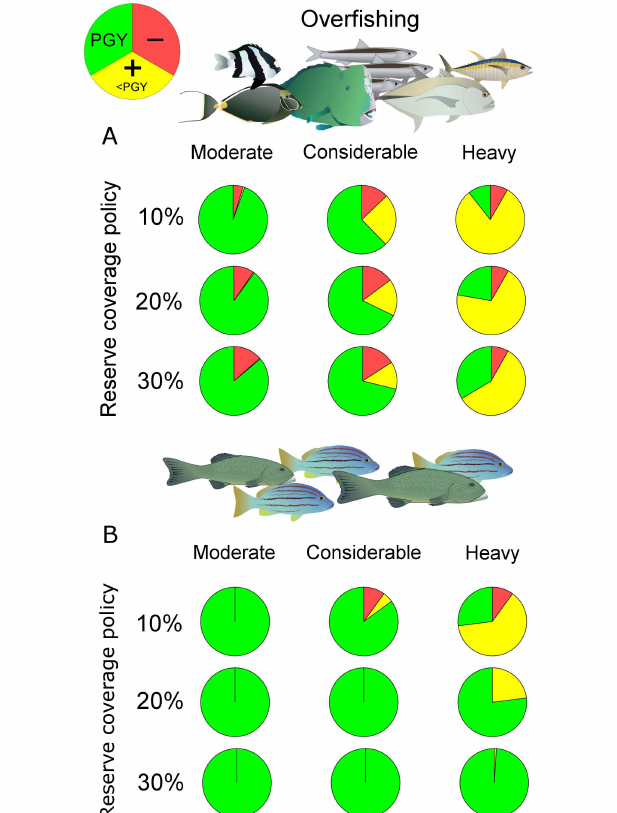
Fig 2. Status and trends of unregulated fisheries under three currently discussed reservecoverage policies. (A) The full range of biological conditionsin generic modellingscenarios( n = 840,950)captured across a gradientin overfishing intensity. (B) As in A but representingfishery scenariosbased on measured reserve sizes, home rangesand larval dispersaldistances ( n = 100) (see K scenariosin Fig 1 and Materials and Methods for details). Green highlightsthe proportionof healthyfisheries, delivering“pretty good yield” (PGY, (cid:21) 80% of the “maximum sustainable yield”) becauseor in spite of reserves. Red and yellow highlight the proportionof depletedfisheries, deliveringless than PGY. While red indicatesthat reserves decreased catch, yellow indicatesthat reserves increasedcatch, albeit not to levels (cid:21) PGY. All data underlying this figure are availableonline(10.5281/zenodo.165189).Images: CatherineCollier (ian-symbol-plectropomus-spp. svg), Joanna Woerner (ian-symbol-naso-lituratus.svg), Jane Thomas